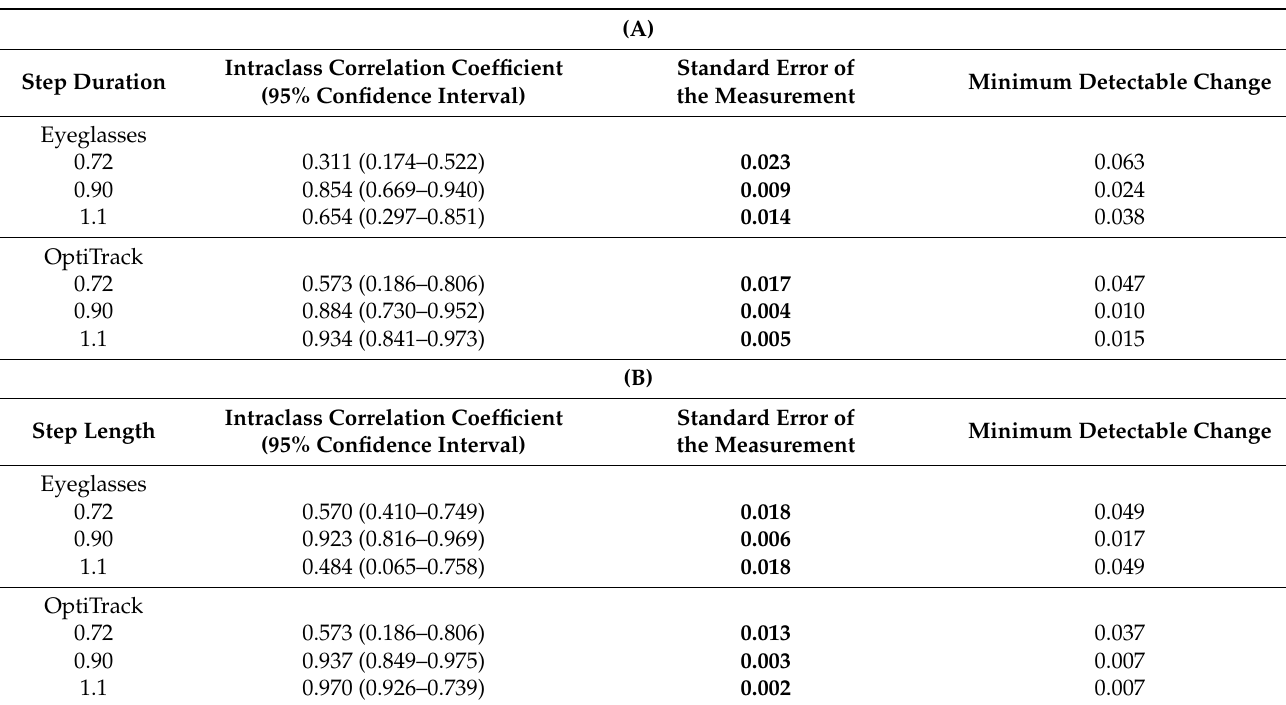
Table 3. Test–retest of the spatiotemporal parameters of the eyeglasses and OptiTrack system without a cervical collar for the three tested speeds. A: step duration and B: step length normalized by the lower limb length.